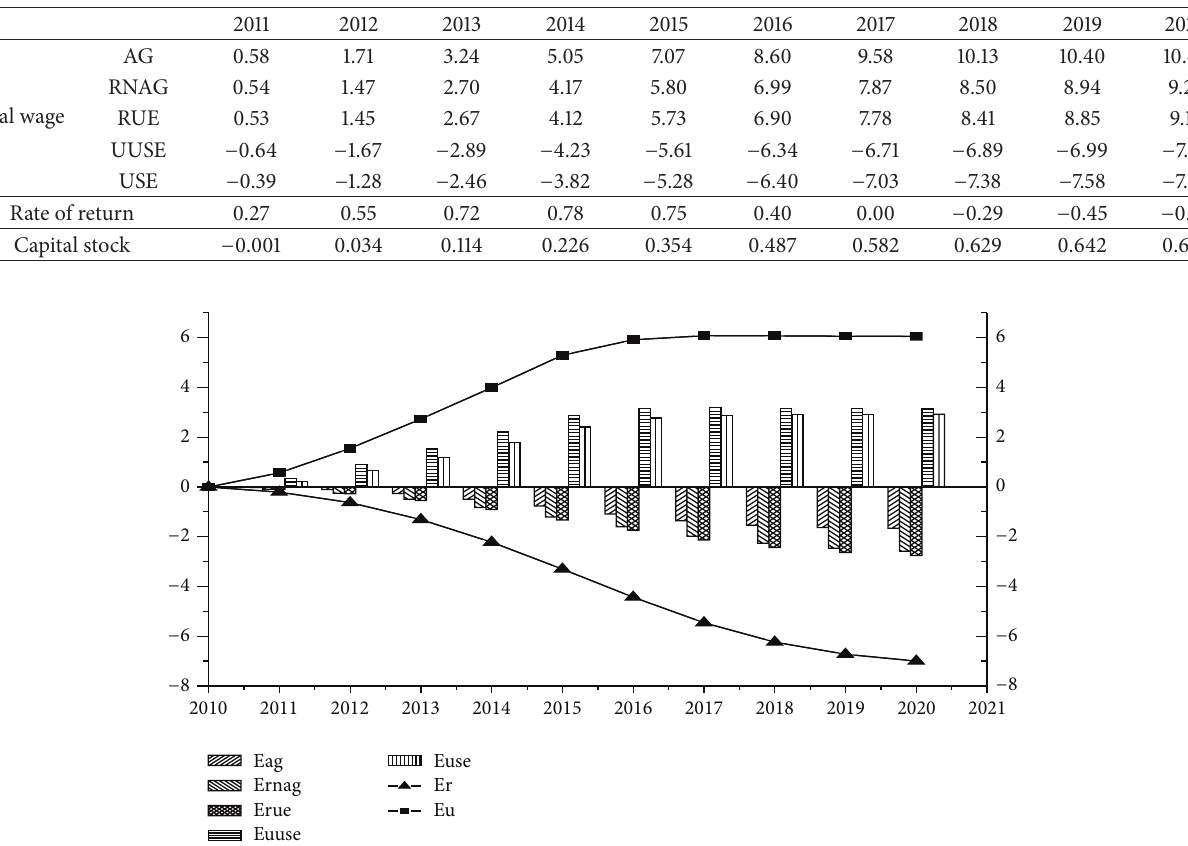
Table 3: The changes of the factor price in 2010–2020 (% change deviation from baseline).